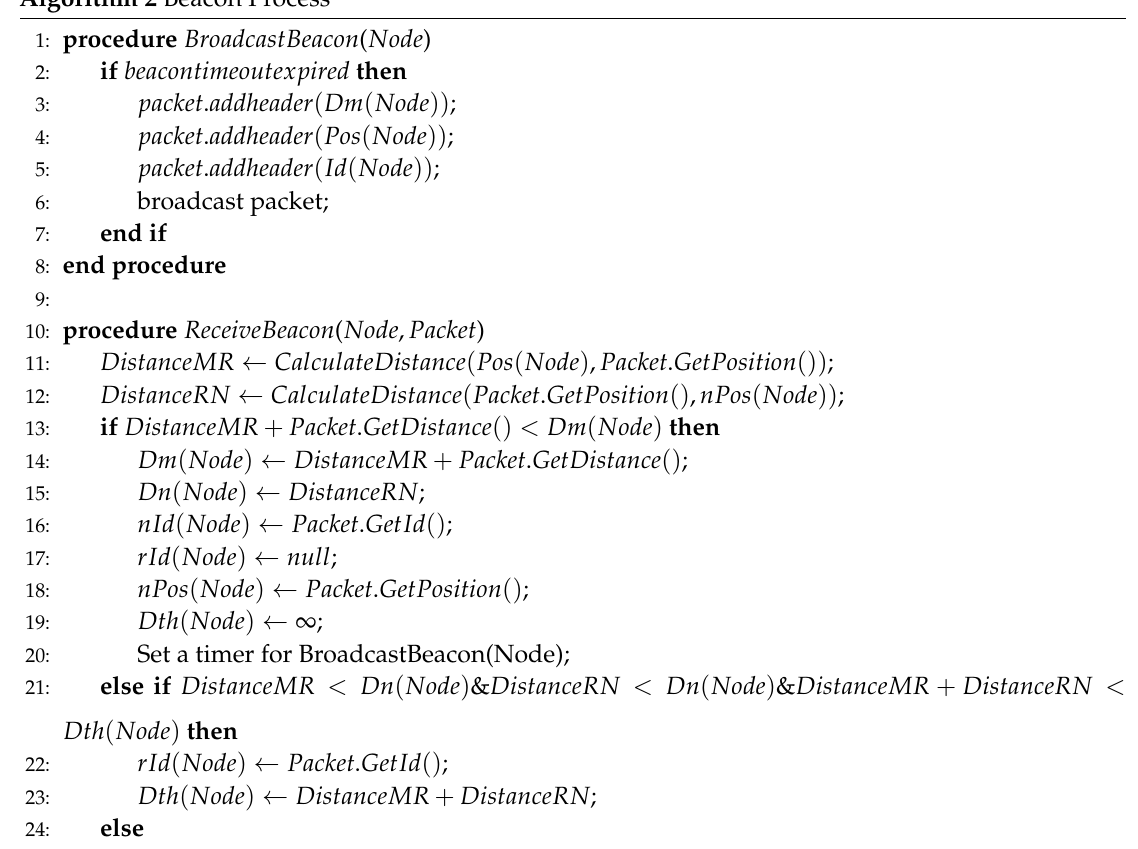
Algorithm 2 Beacon